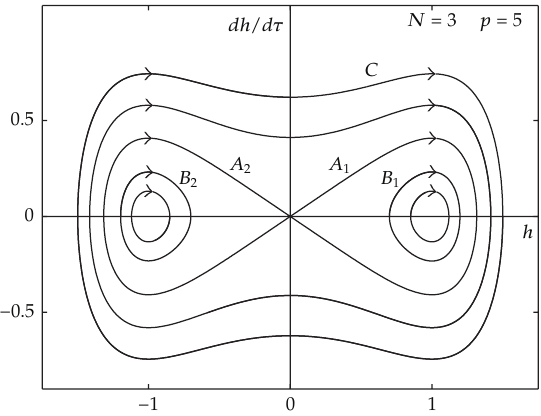
Figure 2: Critical case: N (cid:5) 3, p (cid:5) 5. Periodic and homoclinic orbits of (cid:6) 3.2 (cid:7) proved in Theorem